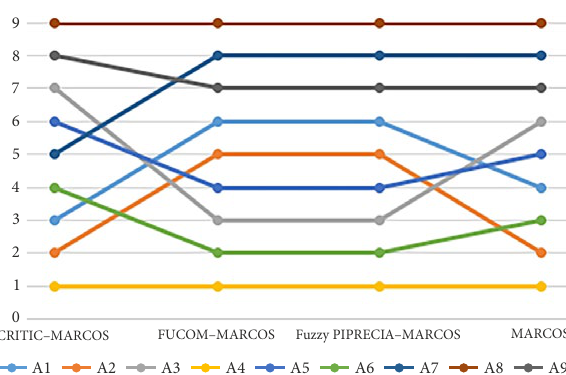
Figure 4. Results of sensitivity analysis – ranks depending on different methods for determining criterion weights